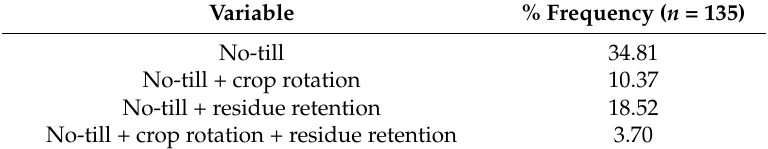
Table 4. Frequencies of the practise of CA components by the sampled Eastern Cape smallholder farmers.